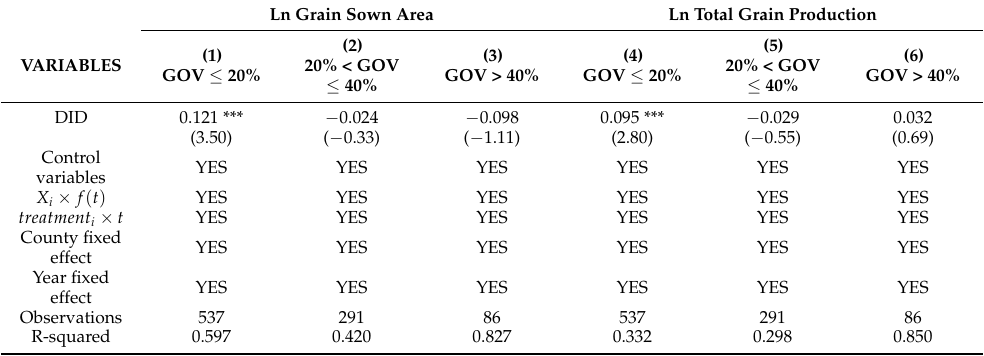
Table 7. Differences in the degree of financial intervention at the county level. Ln Grain Sown Area Ln Total Grain